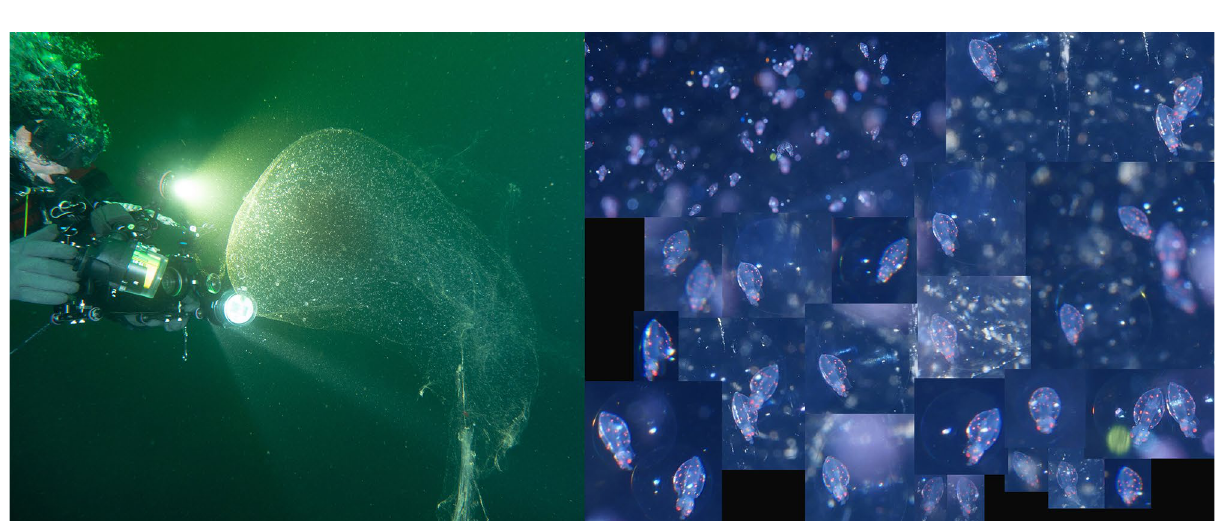
Figure 9. Whole sphere (deformed) with live embryos, photographed in situ from Kristiansand area (sphere observation 24.08.2019). Note the different orientation patterns of the embryos within the jelly envelope, with more or less all heads facing downwards. This sphere has not been genetically tested, but is high likely made by Illex coindetii . (Photo credits: Anita Eliassen (sphere) and Geir Eliassen (embryos)/Arendal undervannsklubb. Collage Halldis Ringvold/Sea Snack